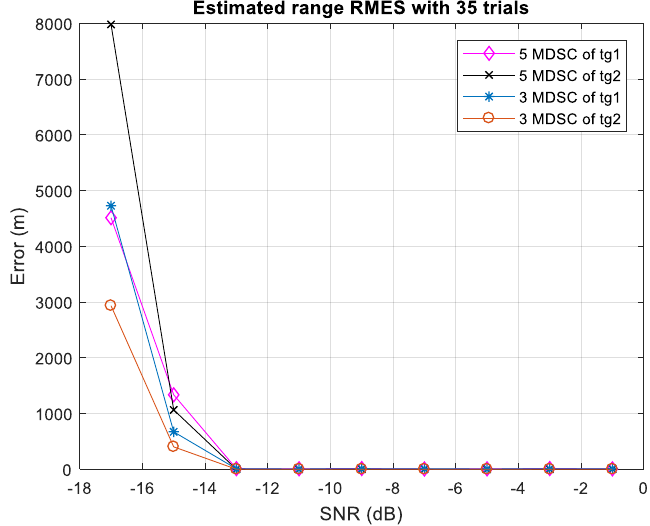
Figure 14. The 3-MDSC and 5-MDSC scheme evaluation error vs. SNR. The estimation error of target-one is marked as blue asterisk line and target-two is the red-circled line. The signal is with 30 dB matched filter pulse compression gain.